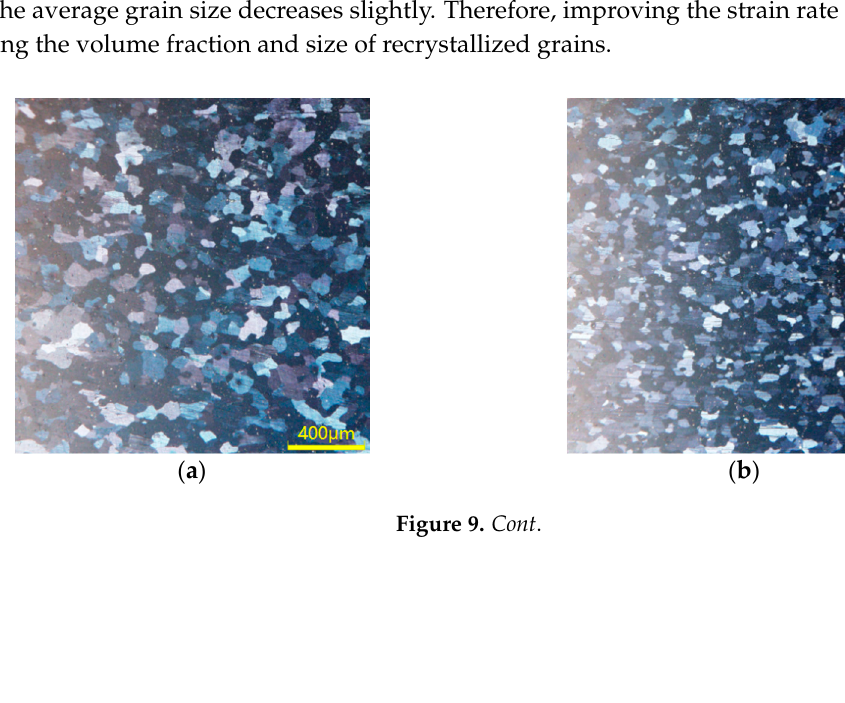
( d ) ( e ) Figure 9. The experimental ( a , b ) and CA ( c , d ) results for microstructures formed at a strain rate of 0.1 s − 1 ( a , c ) and 1.0 s − 1 ( b , d ); ( e ) the variation of the recrystallized volume fraction and the mean grain size at strain rates of 0.1 and 1 s − 1 . 4.4. Delay Time Effect The evolution of SRX and the change in the recrystallized volume fraction at different delay times at a temperature of 450 C  and strain rate of 0.1 s − 1 are shown in Figure 10. Obviously, the recrystallized volume fraction and the recrystallized grain size increase with the increasing delay time, but the rate of increase gradually decreases. The recrystallized volume fraction is 21.89% at 5 s and 80.07% at 60 s, while the mean size of recrystallized grains also increases from 16.20 to 62.50 μ m . Longer delay times provide sufficient time for the growth of recrystallization of grains. However, the process of grain growth is often accompanied by a reduction in energy. As the driving force of grain